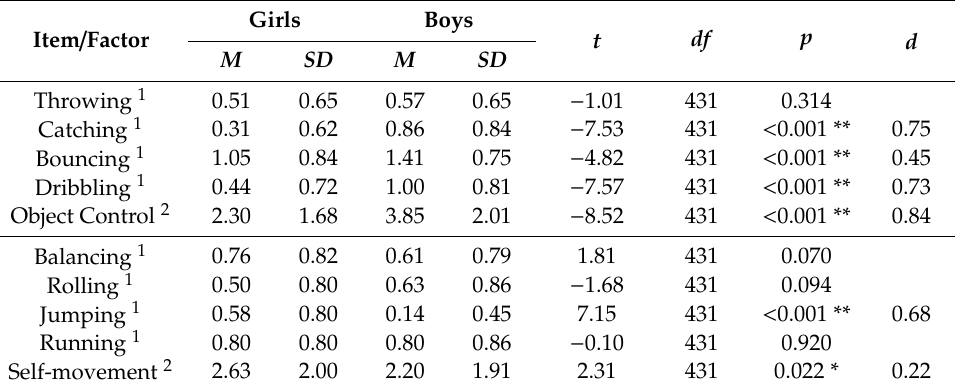
Table 3. Descriptive results of actual MC according to gender 1.